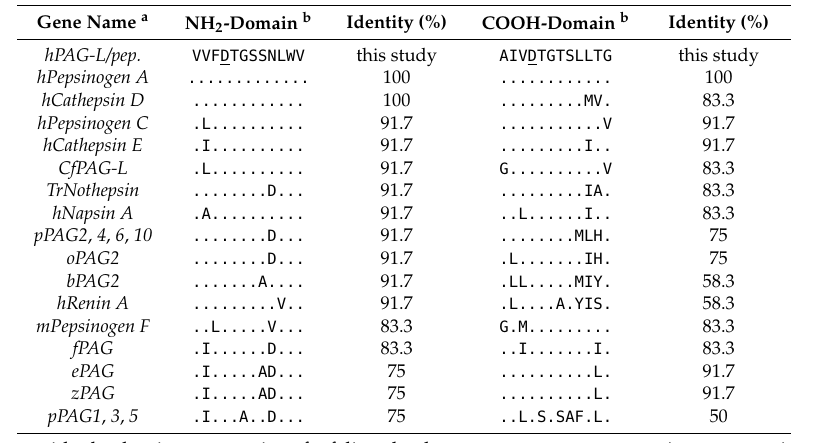
pep A and very homologous to many other APs (Table 3). Surprisingly, no potential N -glycosylation site was predicted in the hPAG-L/pep precursor. In addition, in silico analyses permitted the identification of the molecular mass of the hPAG-L/pep polypeptide precursor (41.993 kDa) and its electrostatic property (pI 3.93). Table 3. Comparison of the aa sequence of NH 2 - and COOH-terminal domains in human PAG-L/pep polypeptide precursor to various aspartic proteinases.